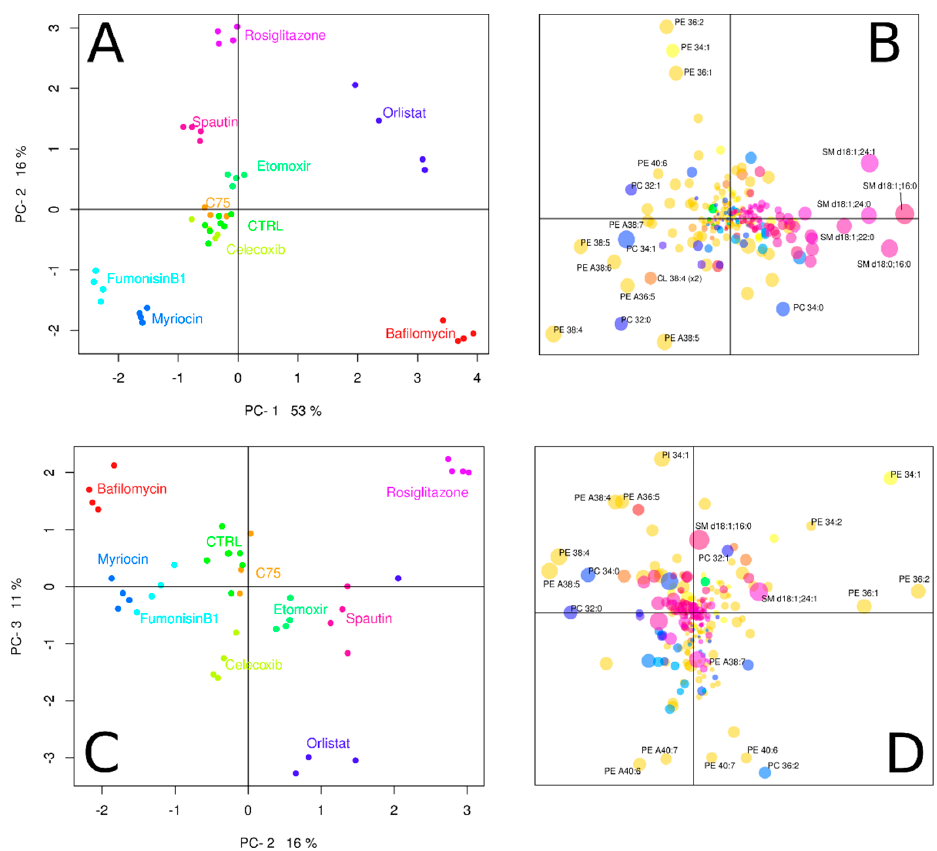
Figure 2. Distinct lipidomic changes are induced by the presence of inhibitors. ( A ) Principal component analysis (PCA) score plot for the different lipidomes (PC ‐ 1 and PC ‐ 2). The CTRL indicates that only DMSO was added to the growth medium (green), bafilomycin (red), C75 (orange), celecoxib (spring green), etomoxir (light green), fumonisinB1 (cyan), myriocin (light blue), orlistat (dark blue), rosiglitazone (purple), spautin (pink). ( B ) PCA loading plot (PC ‐ 1 and PC ‐ 2), lipid species that contributed the most to the variance are labeled, the size of the dots indicates relative abundance. ( C ) Principal component analysis score plot for PC ‐ 2 and PC ‐ 3. ( D ) PCA loading plot (PC ‐ 2 and PC ‐ 3). Sphingosine backbones were assumed for sphingomyelin (SM) species. An ‘A’ in the lipid name indicates the presences of an ether linkage.